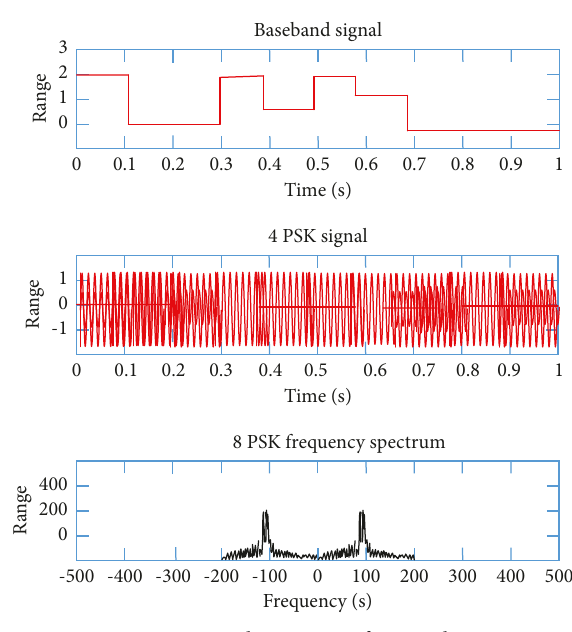
Figure 5: 4PSK time-domain waveform and